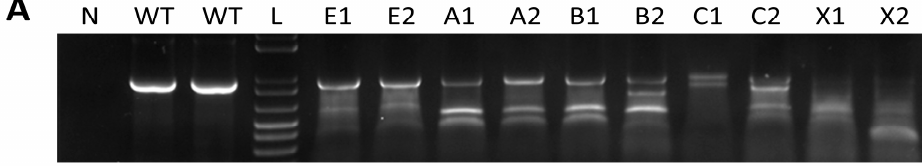
Figure 2. Identification of mutated melanocortin-4 receptor ( mc4r ) gene and integration of sgRNA and Cas9 plasmids in channel catfish, Ictalurus punctatus . N indicates the no-template control, while the WT lane represents samples from wild-type channel catfish. L indicates 1 kb plus DNA ladder (Invitrogen). ( A ) Surveyor-based detection of mc4r gene mutations in pelvic fins from 10 channel catfish. Letters and numbers represent channel catfish tested from different treatments; E1, E2 (electroporated treatment); A1, A2 (MC4RA treatment); B1, B2 (MC4RB treatment); C1, C2 (MC4RC treatment); X1, X2 (MC4RMIX treatment). The presence of two or more additional bands compared to the WT lane indicates the occurrence of mutations. ( B ) Surveyor-based detection of mc4r gene mutations in different tissues from two mutated channel catfish. E, eye; G, gills; I, intestine; M, muscle. ( C ) Integration of Cas9 and sgRNA plasmids in electroporated fish. The plus sign (+) indicates the positive controls (Cas9 and sgRNA plasmids). The plus/minus sign (±) indicates the positive controls and wild-type channel catfish. Numbers represent channel catfish individuals carrying mutated mc4r gene.